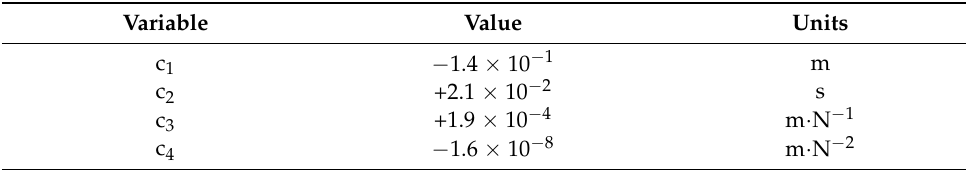
Table 2. Values resulting from a least squares fitting of Equation (6).